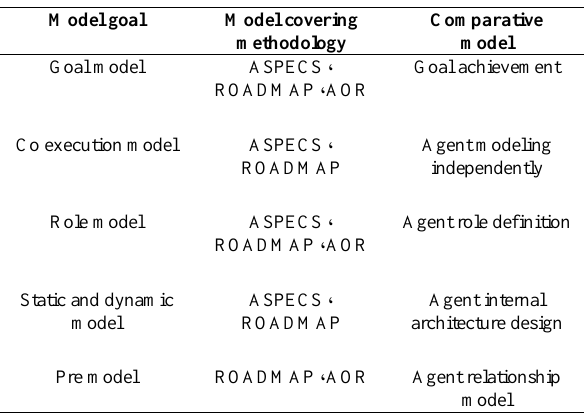
Table3. Methodologies similarities structure analysis. Table 4. Analysis of differences between